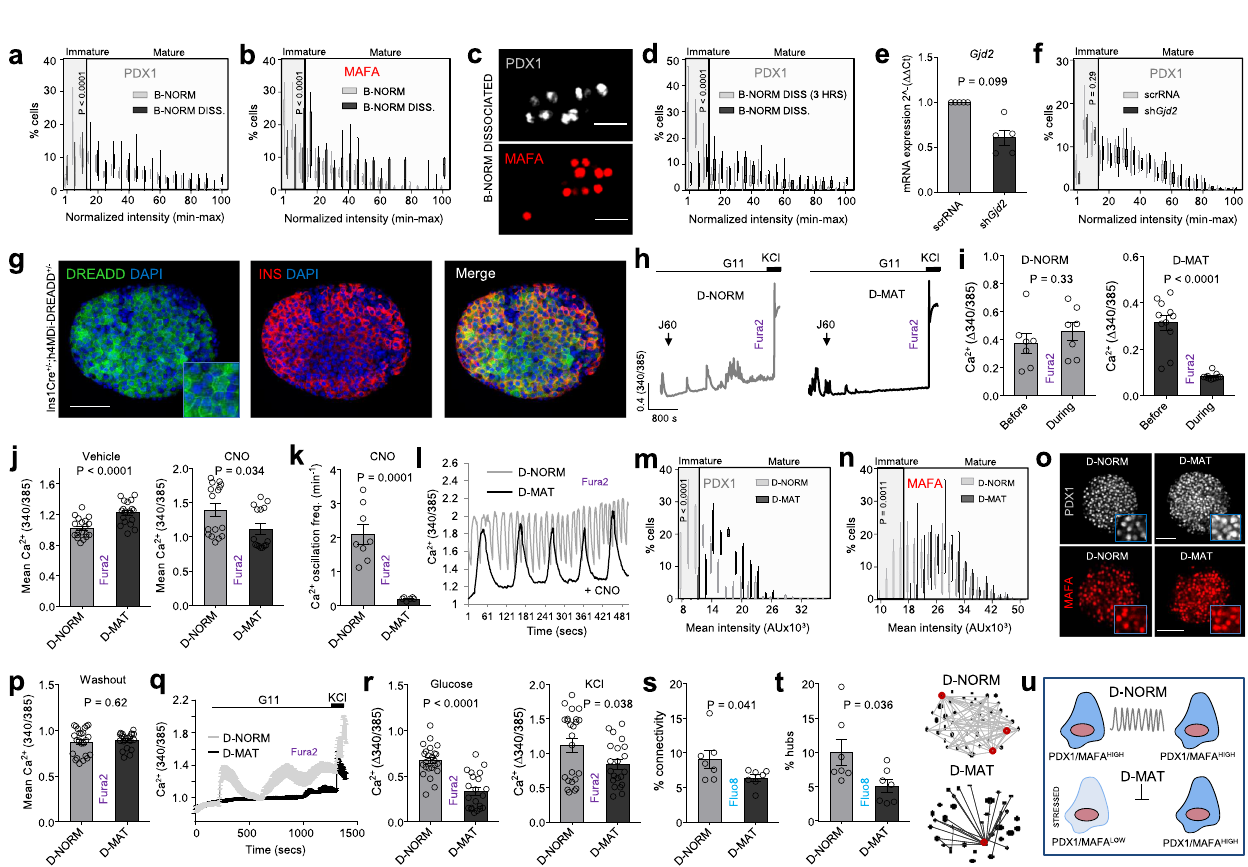
Fig. 7 Differences in PDX1 and MAFA levels are encoded by islet signaling patterns. a – c Islet dissociation (B-NORM DISS.) leads to loss of β -cells in the bottom 15 percentile for PDX1 ( a ) and MAFA ( b ), also shown by representative images ( c ) (B-NORM data are superimposed for comparison) ( n = 6 islets/4 animals; two-way ANOVA, Bonferroni ’ s multiple comparison) (PDX1: F = 7.23, DF = 19) (MAFA: F = 4.69, DF = 20) (scale bar = 42.5 µ m). d PDX1 LOW β -cells are present 3 h following islet dissociation ( n = 80 islets/10 coverslips; two-way ANOVA; Bonferonni ’ s multiple comparison test) (PDX1: F = 9.54, DF = 40) (MAFA: F = 5.22, DF = 20). e , f sh Gjd2 decreases Gjd2 expression ( e ) ( n = 5 animals; paired t-test), but this does not alter the proportion of PDX1 LOW β -cells ( f ) ( n = 8 islets/2 animals; two-way ANOVA, Bonferroni ’ s multiple comparison) (F = 12.85, DF = 20). g – i h4MDi is expressed at the β -cell membrane ( g ) ( n = 3 islets) (scale bar = 85 µ m), allowing silencing of Ca 2 + activity in D-MAT but not D-NORM (control) islets ( h , i ) ( n = 7 islets/3 animals; paired t -test). j 3 h CNO incubation decreases Ca 2 + levels in D-MAT islets (vehicle, DMSO) ( n = 16 islets/5 animals; Mann- Whitney U -test). k , l CNO decreases Ca 2 + oscillation frequency ( k ) in D-MAT islets, also shown by traces ( l ) ( n = 6 islets/2 animals; unpaired t -test). m – o 48 h CNO incubation induces β -cell loss in the bottom 15 percentile for PDX1 ( m ) and MAFA ( n ) in D-MAT islets, also shown by representative images ( o ) ( n = 8 islets/3 animals; two-way ANOVA, Bonferroni ’ s multiple comparison) (PDX1: F = 5.34, DF = 20) (MAFA: F = 4.63, DF = 20) (scale bar = 60 µ m). p 2 h washout restores Ca 2 + levels in CNO-treated islets ( n = 21 islets/3 animals; unpaired t -test). q , r Ca 2 + traces ( q ) showing blunted responses to 11 mM glucose (G11) and KCl (10 mM) ( r ) in D-MAT islets (following CNO washout) ( n = 21 islets/3 animals; unpaired t -test). s , t D-MAT islets display decreases in β -cell – β -cell connectivity ( s ), associated with hub loss (red circles) ( t ) ( n = 7 islets/4 animals; Mann Whitney U-test). u Schematic showing effects of altering Ca 2 + signaling patterns. Bar graphs and traces show the mean ± SEM. Box-and-whiskers plot shows median and min-max. All tests are two-sided where